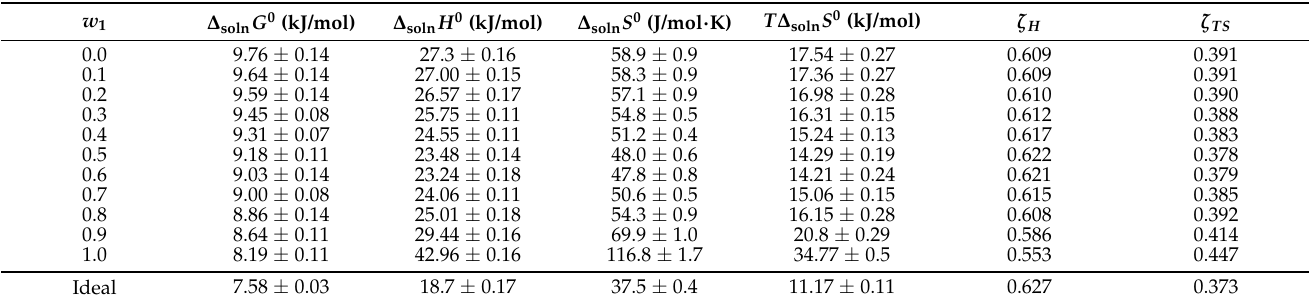
Table 5. Thermodynamic functions of the solution process of isoniazid (3) in (PEG 200 (1) + water (2)) cosolvent